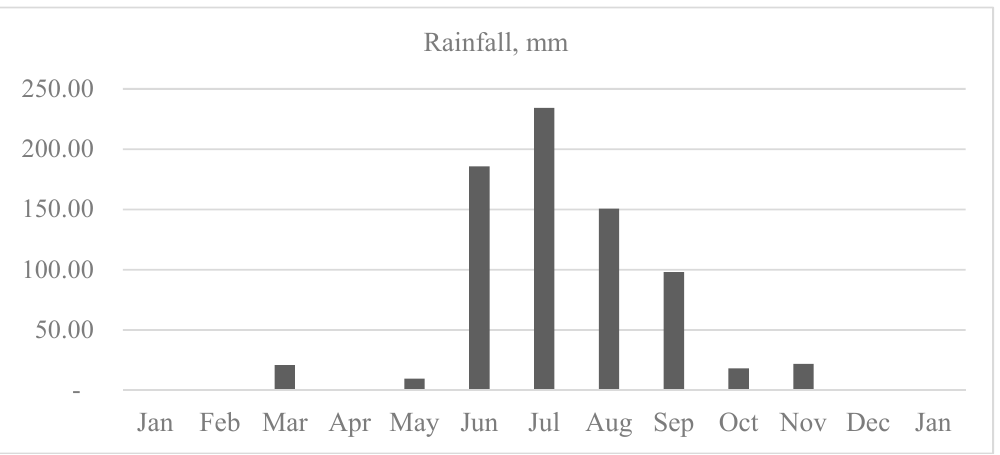
Figure 4. Amount of rainfall during the period of January 2016 to January 2017 in the meteorological station located in Guadalajara.